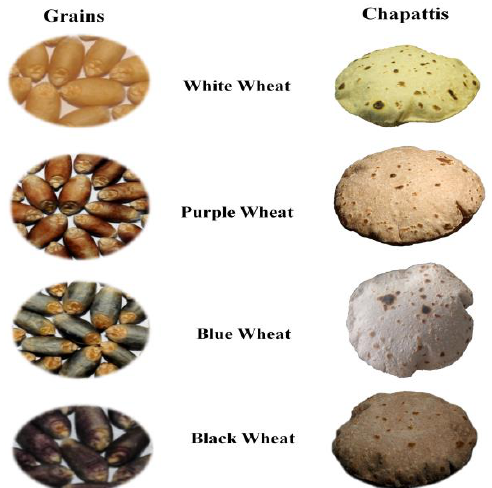
Figure 1. Seeds and chapatti of white and different colored wheat .